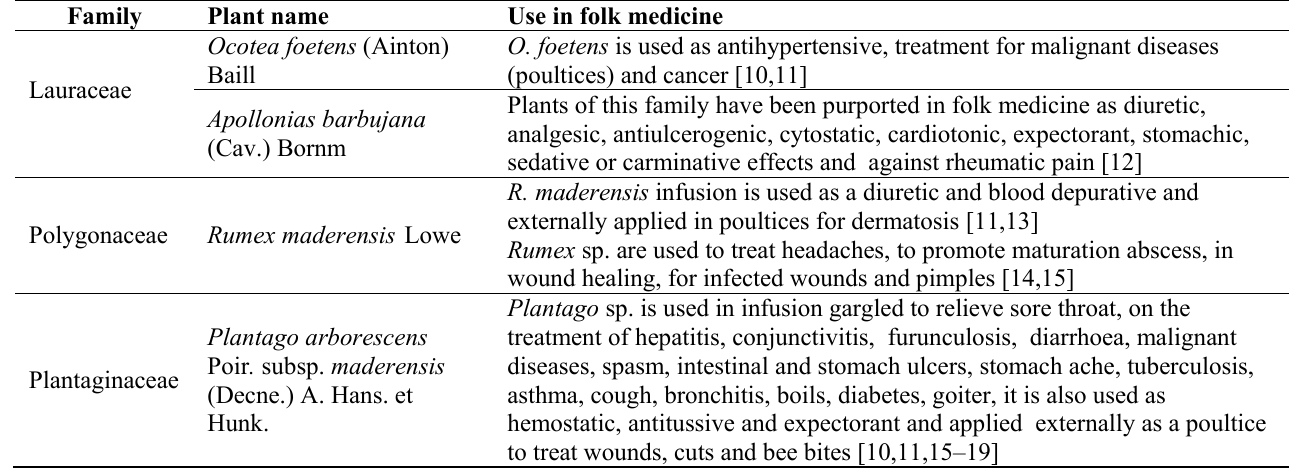
Table 1. Folk medicinal uses of O. foetens , A. barbujana , R. maderensis , P. arborescens subsp. maderensis and P. azorica